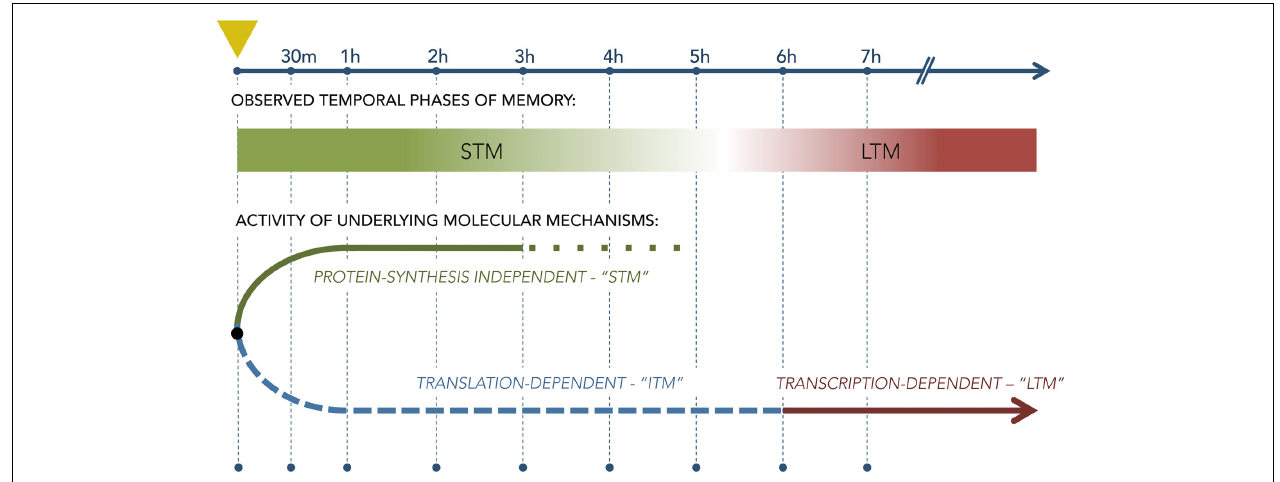
FIGURE 6 | Diagram of the separate molecular pathways underlying short-term and long-term memory as derived from studies using single-trial aversive training paradigms. Leftmost dashed vertical line (markedwithyellowtriangle)denotesthethetimeofconditioning;subsequent vertical lines denote timepoints following the trial. The lower diagram